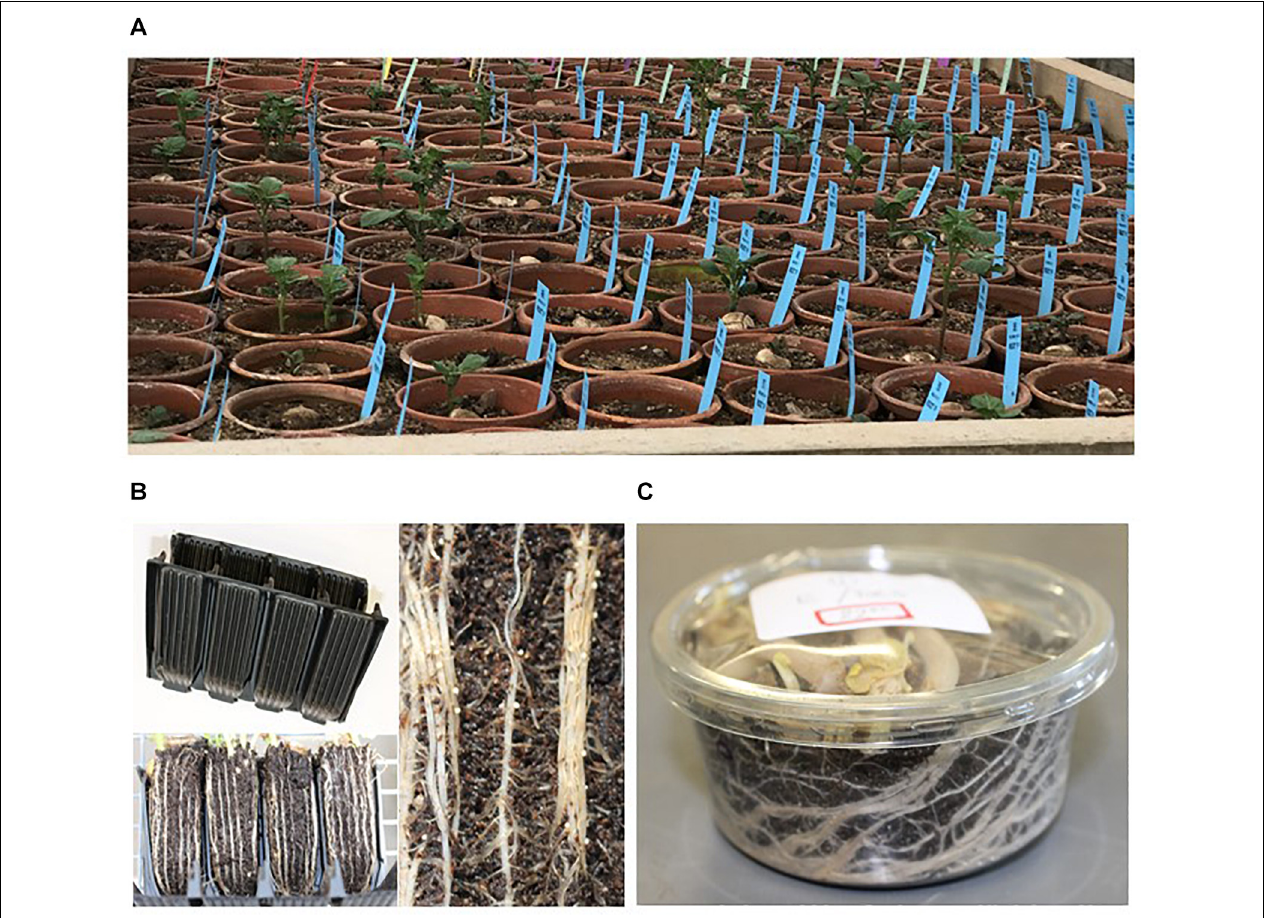
FIGURE 3 | Methods for assessing PCN resistance in potatoes: (A) clay pots with potato plants growing in a sand/loam mixture which has been inoculated with cysts, (B) empty rootrainer cassette, 4 root systems in rootrainer with roots growing on surface of compost and female nematodes on root surface, (C) transparent canister with potato roots visible for counting female